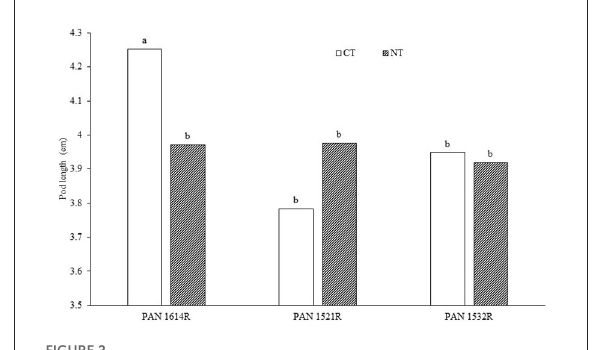
FIGURE2 Interactive effects of cultivar and tillage on pod length on a soybean cropping system. Levels with same letter are not significantly different.